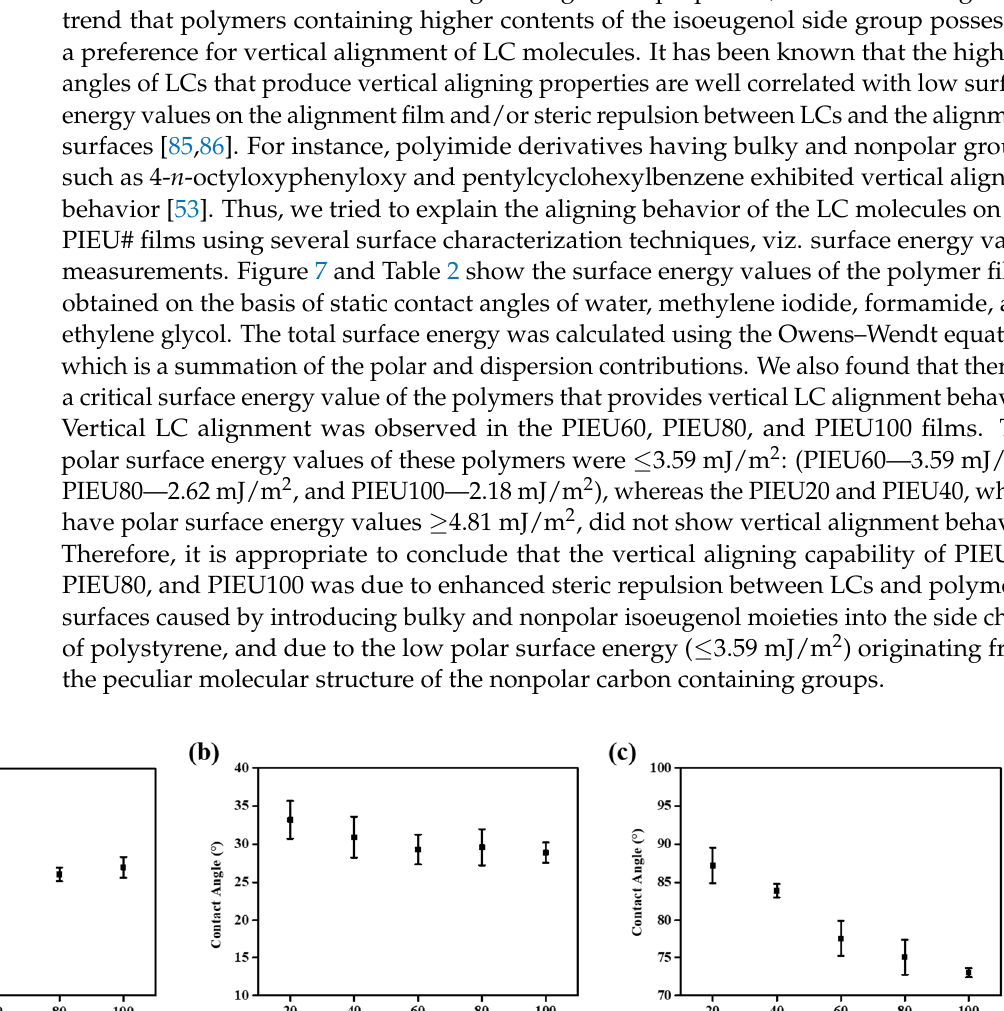
a Measured from static contact angles. b Calculated from Owens–Wendt’s equation. c Circle (O) and cross (X) indicate polymer films have vertical and random planar, tilted LC aligning ability, respectively. 3.4. Reliability and Electro-Optical Performance of the LC Cells Fabricated with Isoeugenol- Modified Polystyrene Films The reliability of the LC cells made from the polymer films was investigated through a stability test of the LC alignment under harsh conditions such as high temperatures and ultraviolet (UV) energy. The thermal and UV stabilities of the LC cell made from the PIEU100 film were estimated from the POM image after heating for 1, 5, and 10 min at 100, 150, and 200 °C, and UV irradiation at 5, 10, and 15 J/cm 2 , respectively. As shown in Figure 8, no significant difference in the pretilt angle on the PIEU100 film with vertical LC alignment ability was observed through the Maltese cross-pattern in the conoscopic POM images, indicating that the vertical LC alignment ability of the PIEU100 LC cell was main- tained even at a high temperature of 100 °C and an UV energy of 15 J/cm 2 . The total surface